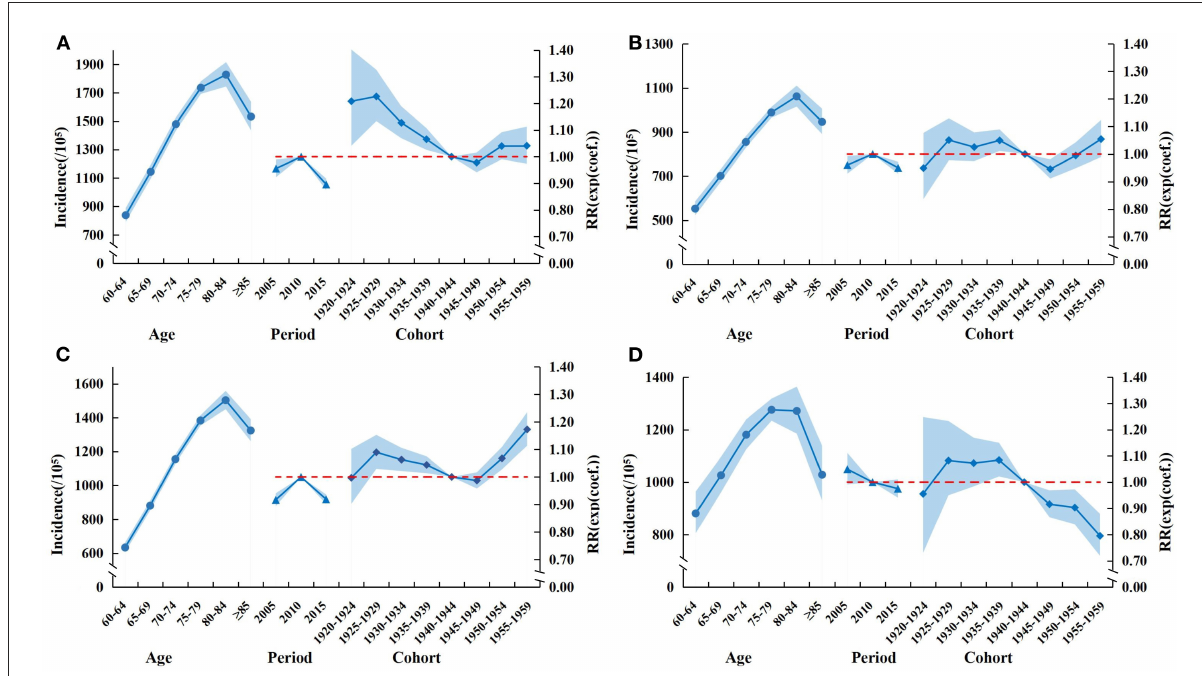
FIGURE2 Age-period-cohort model of cancer incidence in Chinese older adults aged 60 and above from 2005 to 2016. (A) Male. (B) Female. (C) Urban. (D)